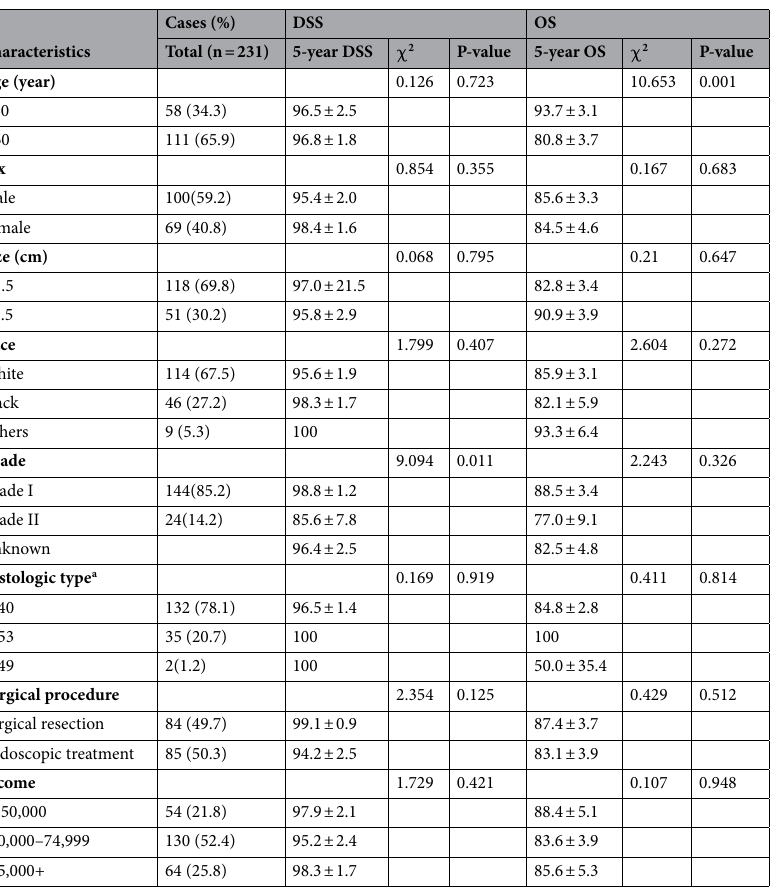
Table 3. Factors associated with disease-specific survival and overall survival after PSM for non-ampullary duodenal neuroendocrine tumors (d-NETs) patients with T2N0M0 stage. DSS disease-specific survival, OS overall survival, PSM propensity score matching. a International Classification of Diseases for Oncology,